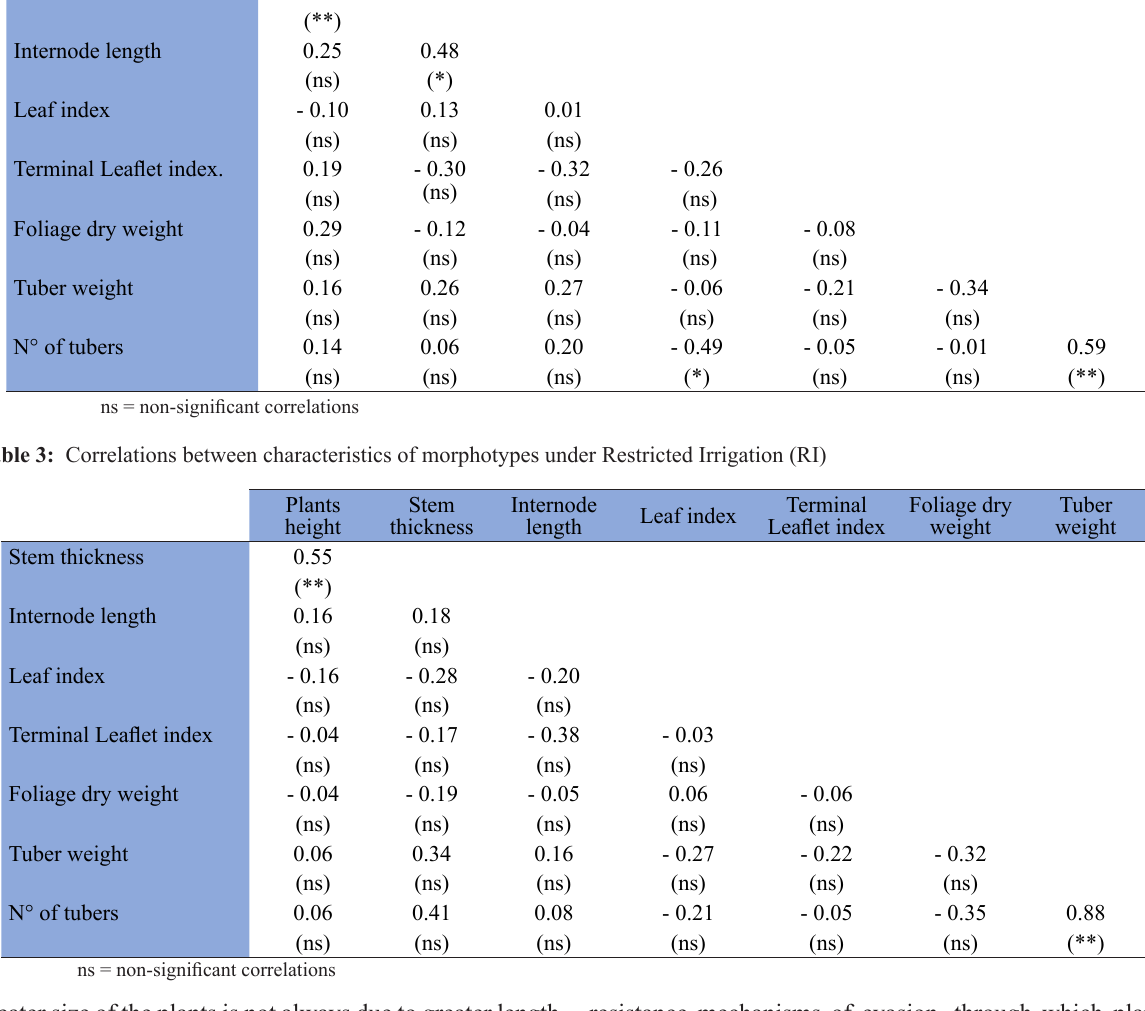
Table 2: Correlations between characteristics of morphotypes under Continuous Irrigation (CI)